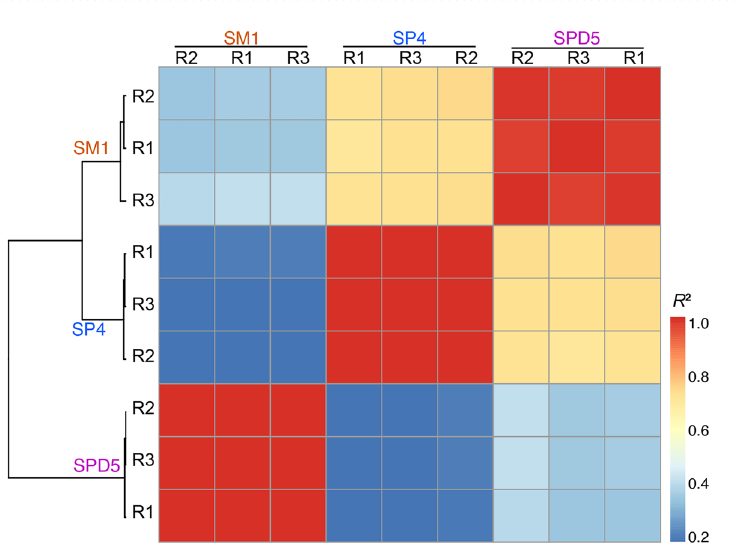
Figure 4. Clustering of samples using FPKM values of all unigenes. Hierarchical clustering of samples was performed using FPKM values of sense transcripts from all derived gene models. The trees were depicted with the ‘cor’ package for R, by using the average linkage distance measurement and Pearson’s